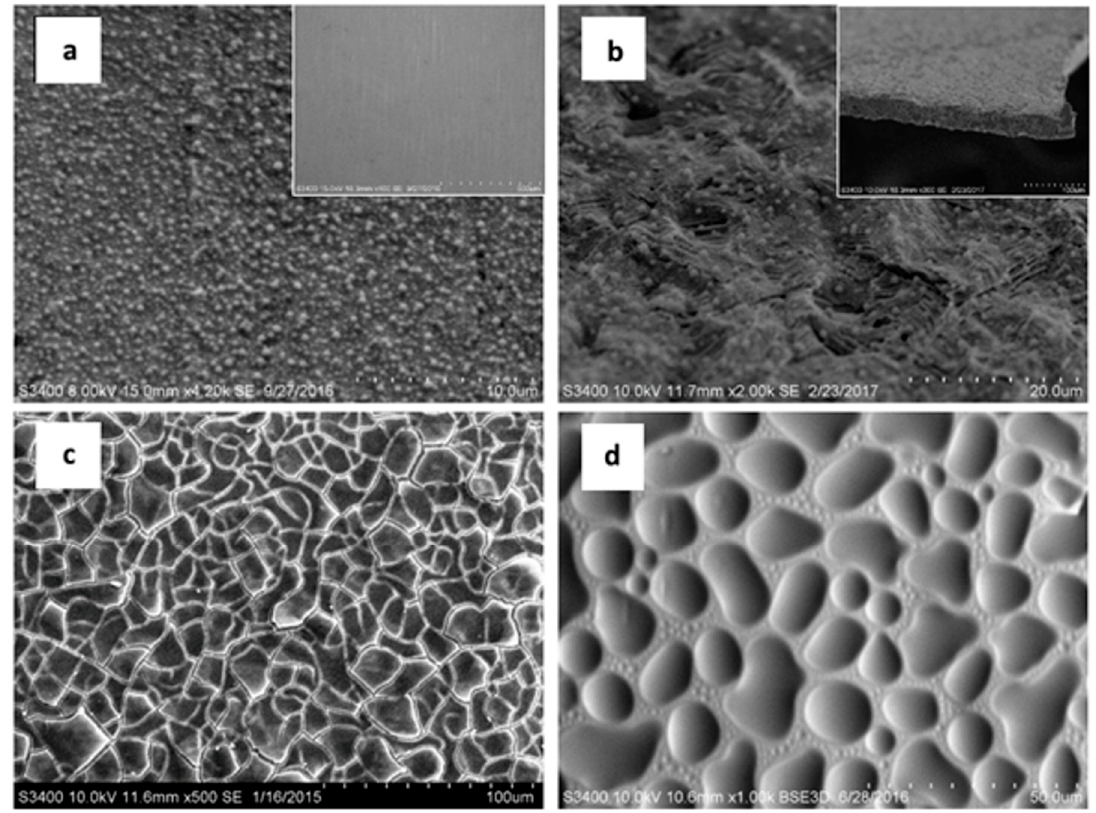
Figure 8. SEM micrographs of silica coatings with different morphologies. ( a ) SiO 2 coating on the surface of stainless steel: Note the surface appears smooth at low magnification, while a good distribution of visible particles of silica is observable at high magnification. ( b ) SiO 2 coating on the surface of a titanium alloy substrate after an expansion test: Note it is difficult to see at low magnification, while at high magnification there are visible silica particles. In addition, an interesting property of this coating is its flexibility. ( c ) A cracked SiO 2 coating on steel. ( d ) SiO 2 coating with bubbles on the surface of the steel.